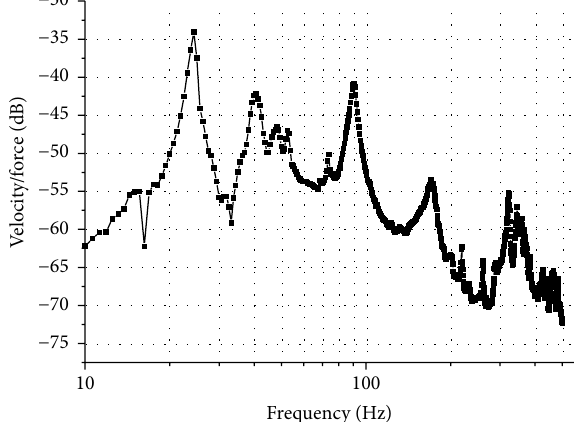
Figure 22: Average velocity response function of the verification base (dB-Reference: 0 dB = 1